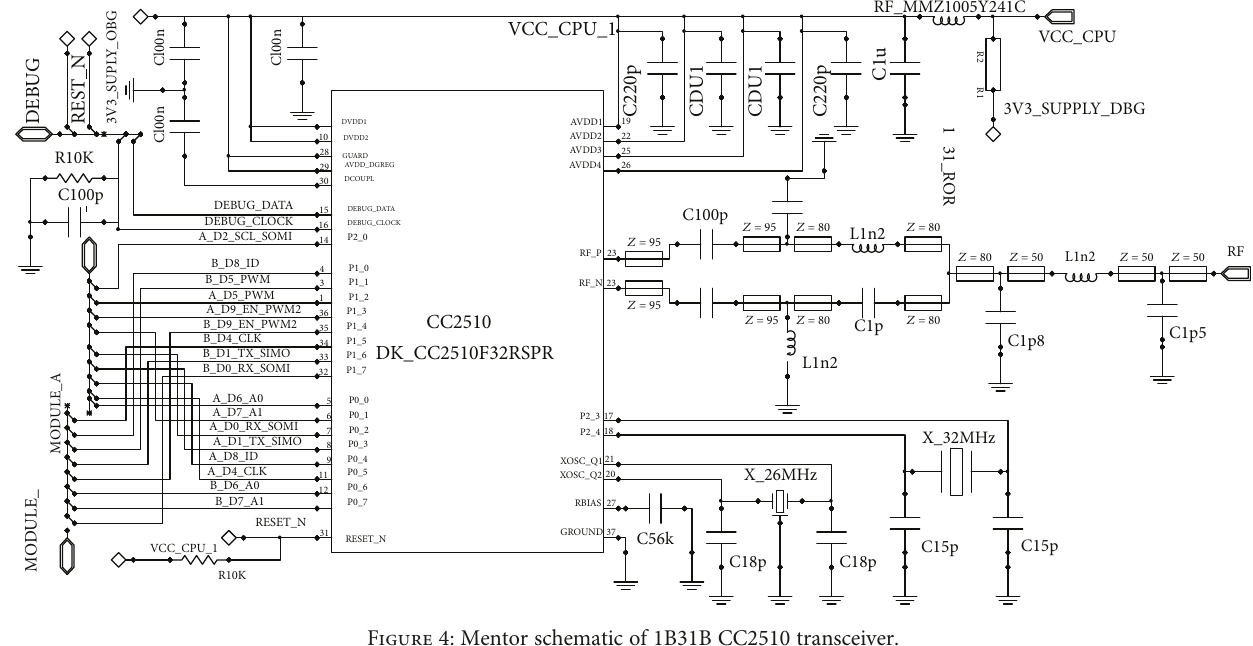
Figure 4: Mentor schematic of 1B31B CC2510 transceiver.